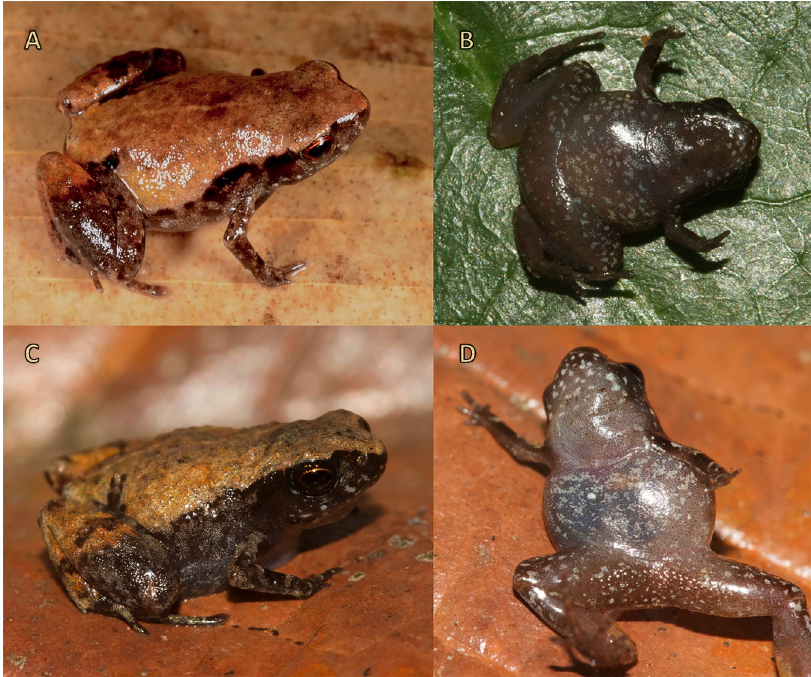
Figure 4. Photographs of live specimens of Noblella losamigos sp. n. ( A , B ) Adult male paratype MUSM 37357 (SVL 10.3 mm). ( C , D ) Adult female paratype MUSM 37356 (SVL 9.7 mm). Photographs by Roy Santa-Cruz. Diversity 2019 , 11 , x